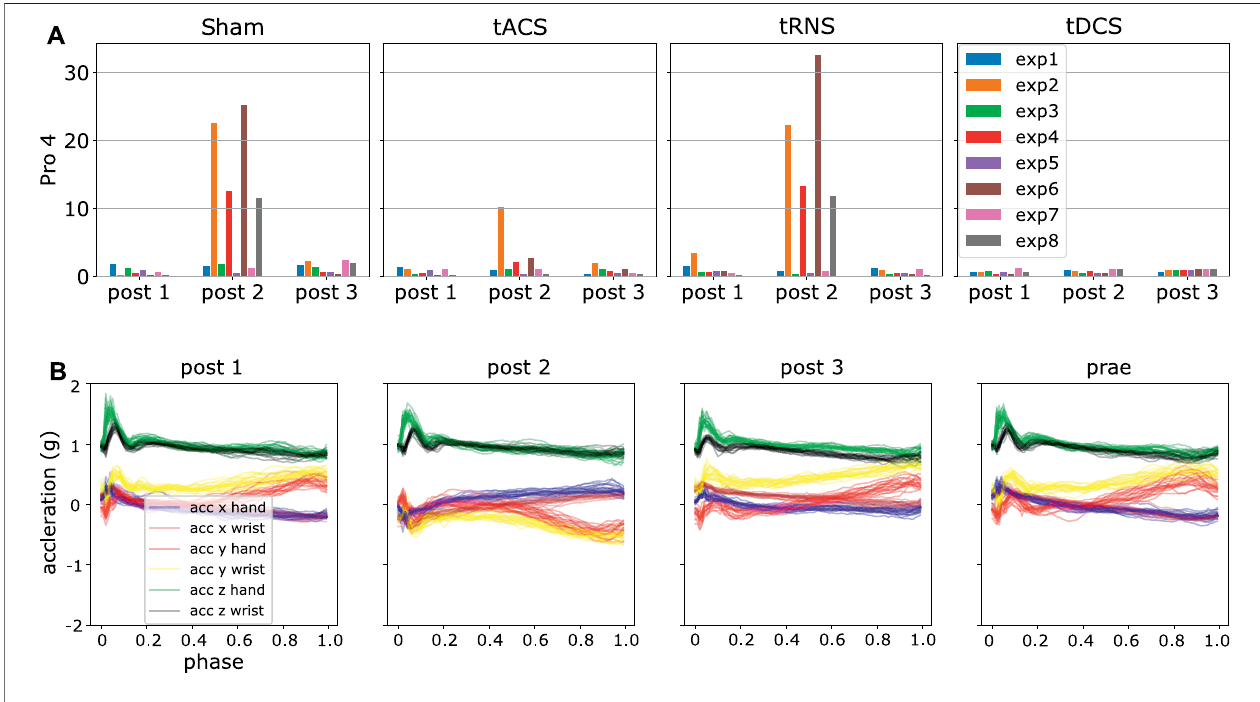
FIGURE8| UsingProMPswithsymmetricKL-divergencehelpsdetectpotentialdataanomalies. (A) PotentialanomaliesinhighKL-divergencecase,i.e.,high D KLS case (B) Flipping of the blue, red, brown and yellow curves, i.e., x , y -axis recordings in hand and wrist in post 2 .